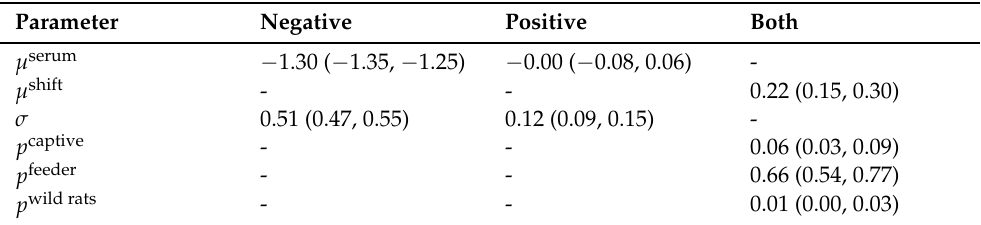
Table 2. Posterior estimates of the model parameters, with a 95% credible interval. Parame- ters µ shift and p study are estimated at the study level, and are not different for the negative or positive components.